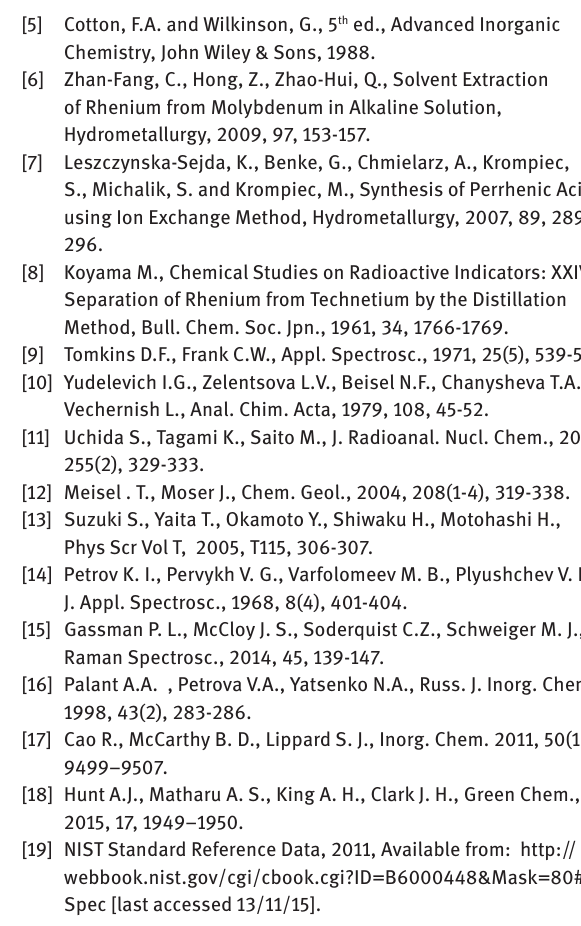
Distillation Purity of APR Chloride % Nitrate % Sulphate % Distillation: Fraction 3 Distillation: Fraction